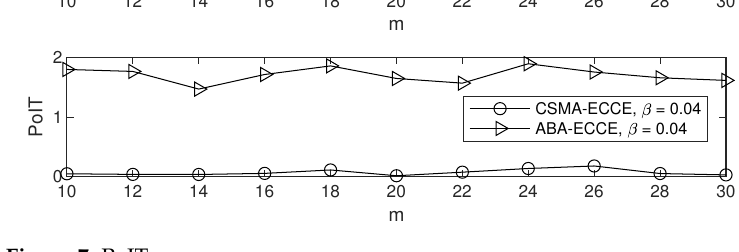
Figure 7. PoIT vs. m .